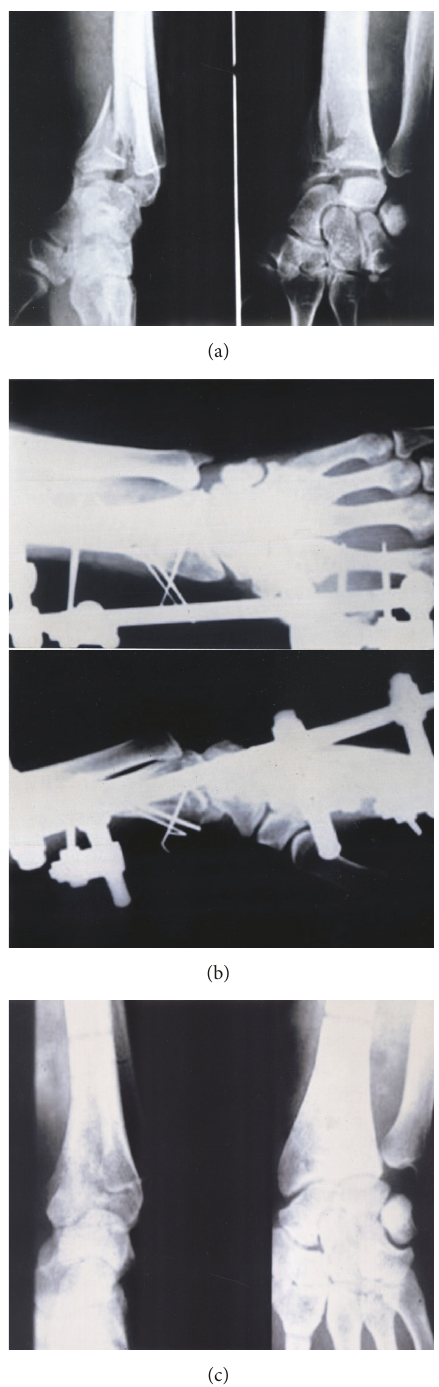
Figure 2: Preoperative (a), postoperative (b), and final follow-up radiographs of EFK group